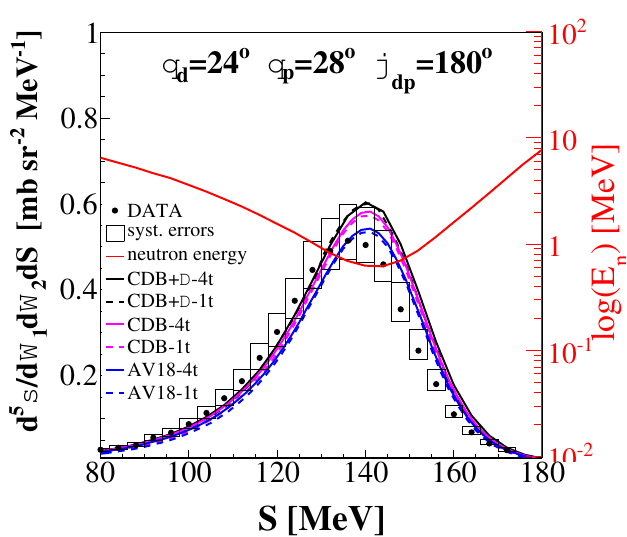
Figure 2: (Color online) Differential cross section as a function of the kinematical variable S for the angular configuration specified in the panel. The experimental points are marked with black dots with total systematic errors depicted as empty boxes. Various lines represent the theoretical predictions calculated at the central values of the defined angular bins. The black lines refer to the SSA calculations based on the CD Bonn + ∆ (CDB + ∆ ) potential: solid with 4-term (4t) and dashed with 1-term (1t). Solid and dashed magenta (light gray) and blue (dark gray) lines represent the similar set of the calculations but for the CD Bonn and AV18 potentials, respectively. The solid red line (upper line) presents the dependence of the spectator neutron energy (E ) on the S variable. For details see also Ref. [ 38 ] n